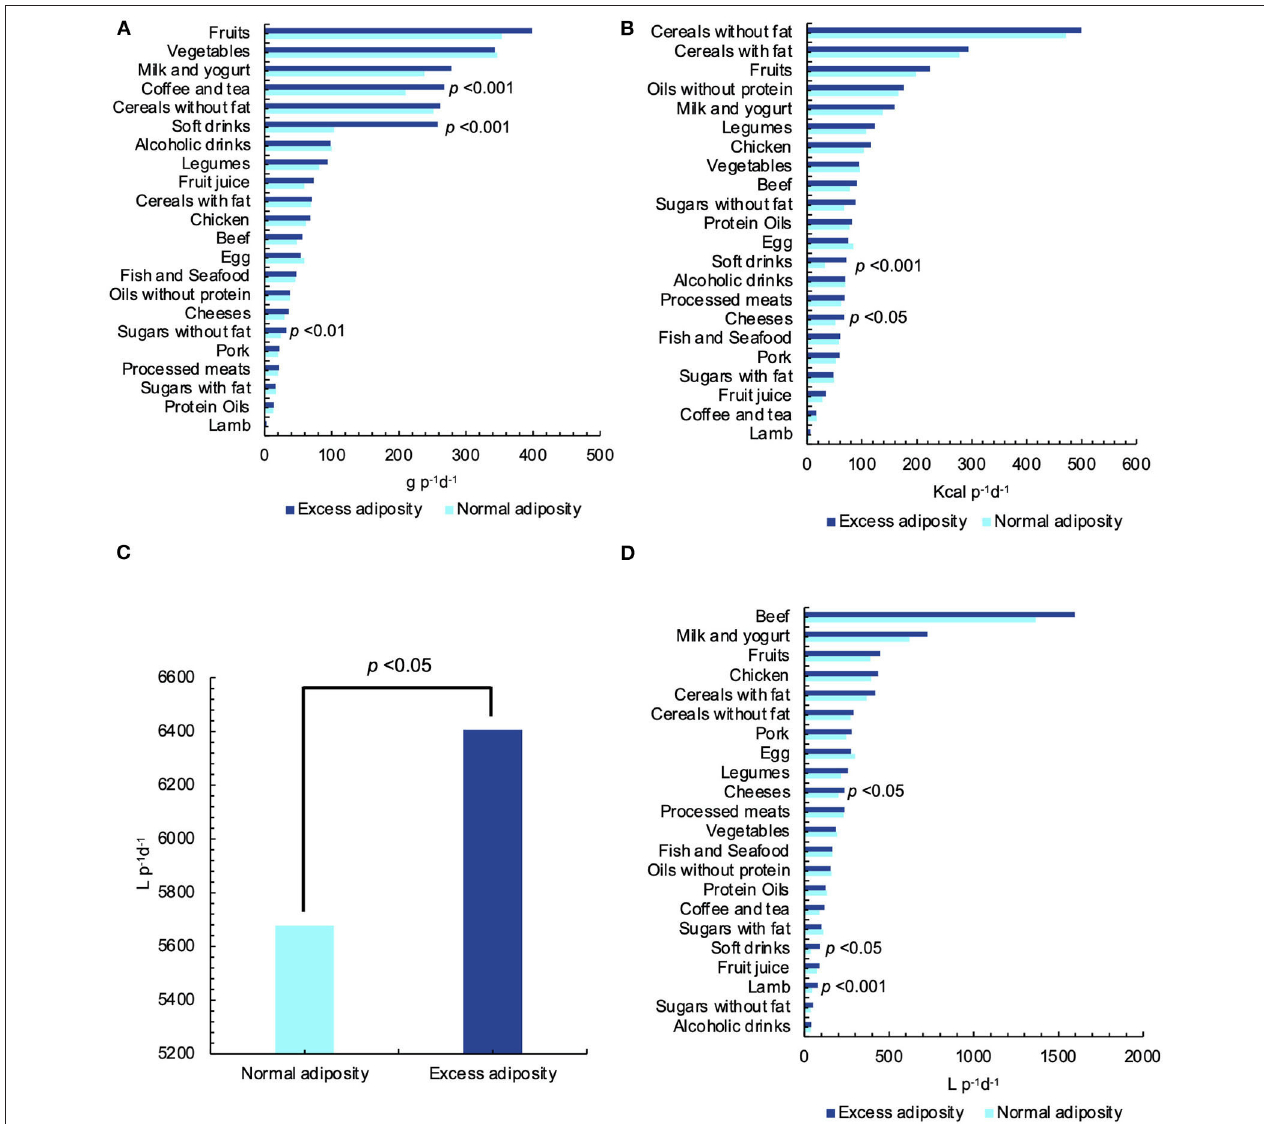
FIGURE 5 | Food and caloric intake and its water footprint (WF) by food groups in the adiposity groups. Statistical significance was considered at p ≤ 0.05. (A) Food groups consumed by adiposity groups. (B) Caloric intake by adiposity groups. (C) Total water footprint (WF) by adiposity groups. (D) Total water footprint (WF) of food groups by adiposity